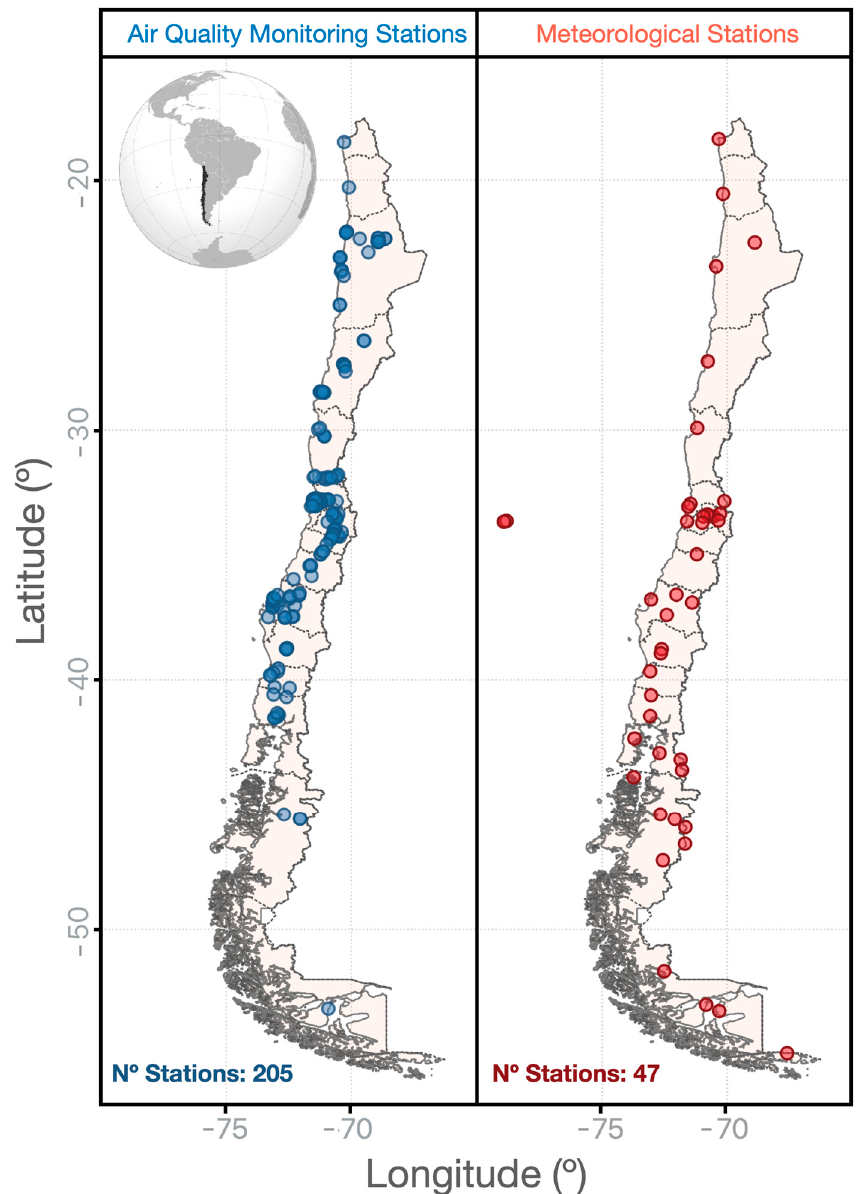
Figure 1. Location of air quality monitoring stations and meteorological stations included in the ChileAirQuality.